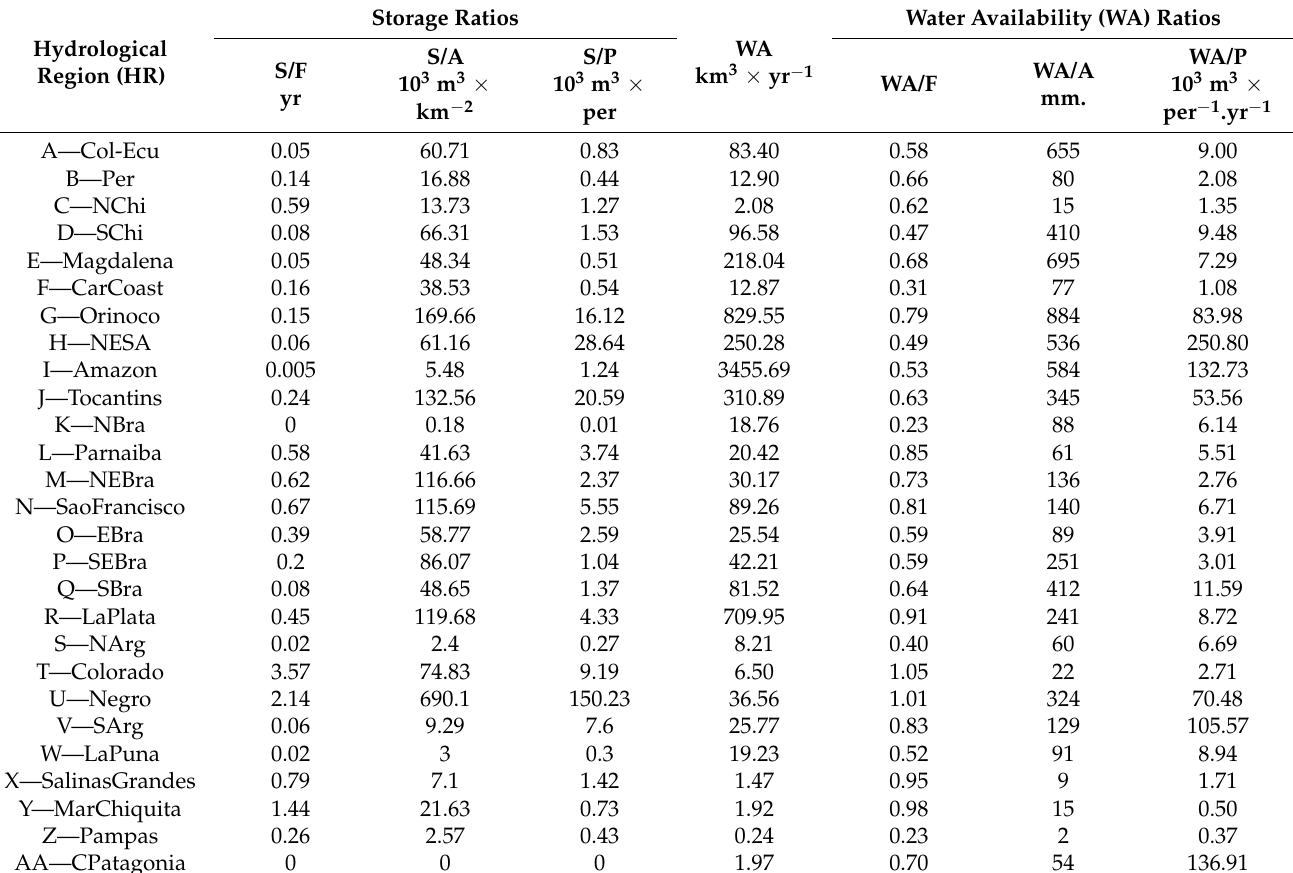
Table 2. Storage and water availability ratios for the hydrological regions of South